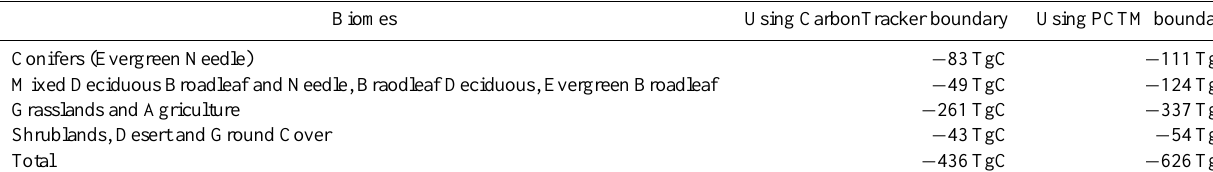
Table 2. Total Posterior Net Ecosystem Exchange by Biome (negative indicates “into biosphere”).